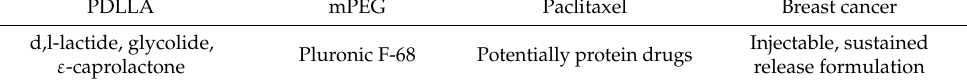
Table 4. Block-copolymer/surfactant-based formulations for innovative drug delivery applications.